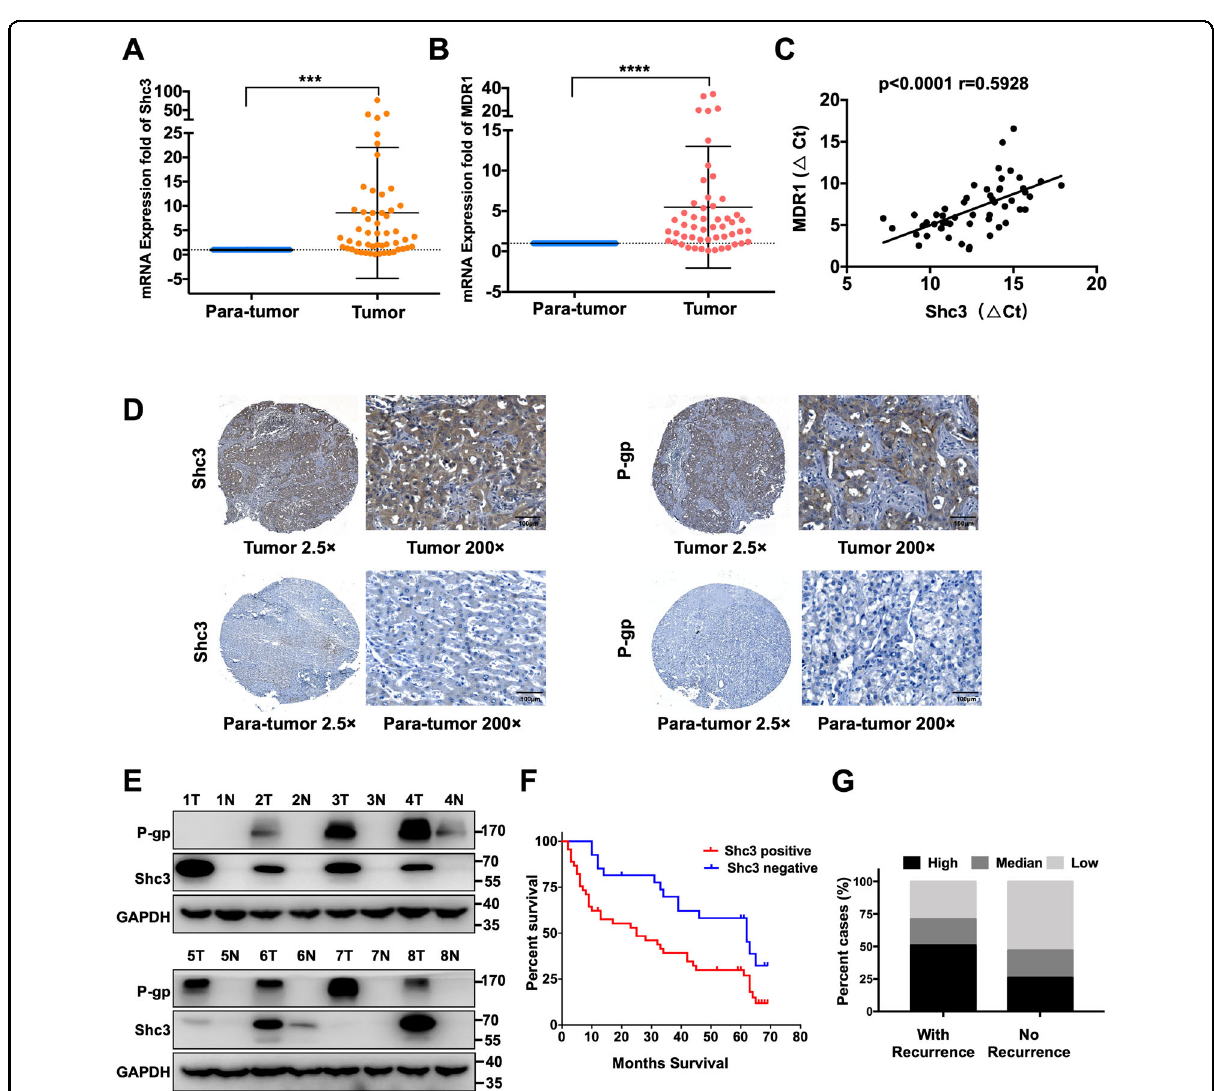
Fig. 1 Shc3 is a critical oncogene linked to hepatocellular carcinoma (HCC) drug resistance. A The mRNA levels of Shc3 in 52 paired HCC tissues. Shc3 mRNA expression in HCC clinical samples and para-tumor samples were compared using paired Student ’ s t -test, *** P < 0.001. B The mRNA levels of MDR1 in 52 paired HCC clinical tissues. Data represent the mean ± SD (**** P < 0.0001, by Student ’ s t -test). C The correlation between Shc3 and MDR1 expressions in 52 paired HCC samples (Pearson ’ s correlation coef fi cient, R = 0.5928, P < 0.0001). D Representative immunohistochemistry analysis of Shc3 and P-gp expression in 72 paired HCC tissues (magni fi cations: ×2.5 and ×200). E Western blot analysis of Shc3 and P-gp expression in 8 pairs of HCC and non-tumor liver tissues. T, HCC tissues; N, non-tumor liver tissues. F Kaplan – Meier ’ s correlation analyses between Shc3 expression levels and overall survival. G According to the IHC staining intensity, the expression levels of Shc3 in 72 HCC patients were classi fi ed as low, medium, and high. The correlation of Shc3 expression and HCC recurrence was